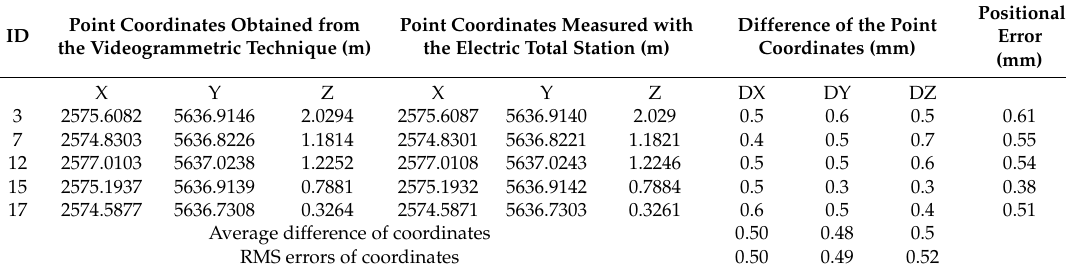
Figure 7. The control points and checkpoints distributed in the first frame of video-frames from the three high-speed CMOS cameras. (L): Control points and checkpoints in the first frame from the left camera; (M): Control points and checkpoints in the first frame from the middle camera; (R): Control points and checkpoints in the first frame from the right camera. Table 2. Accuracy of the point coordinates from the videogrammetric system.